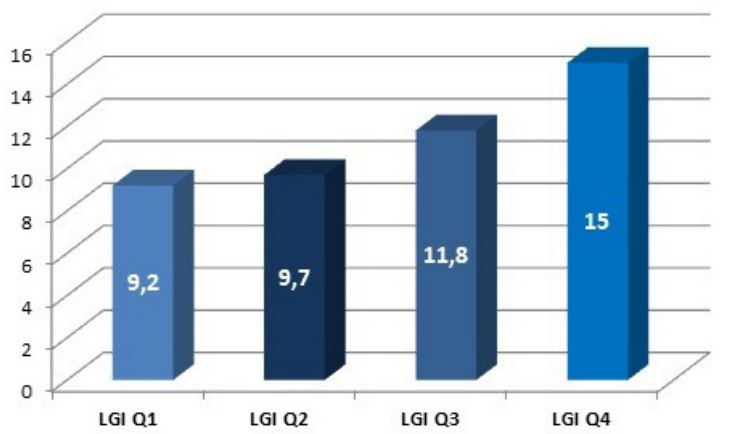
Fig. 1 - Incidence (%) of primary combined endpoint according to the leuko- glycaemic index (LGI).